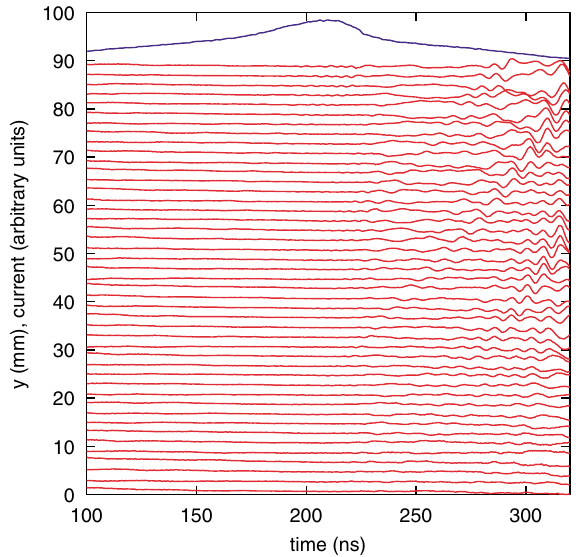
FIG. 3. (Color) Mountain range plot of transverse position along a PSR bunch (red) and the beam current (blue). The total time was 490 (cid:16) s , increasing vertically, with every 30th turn plotted. The rf voltage was 10% above the threshold for fast